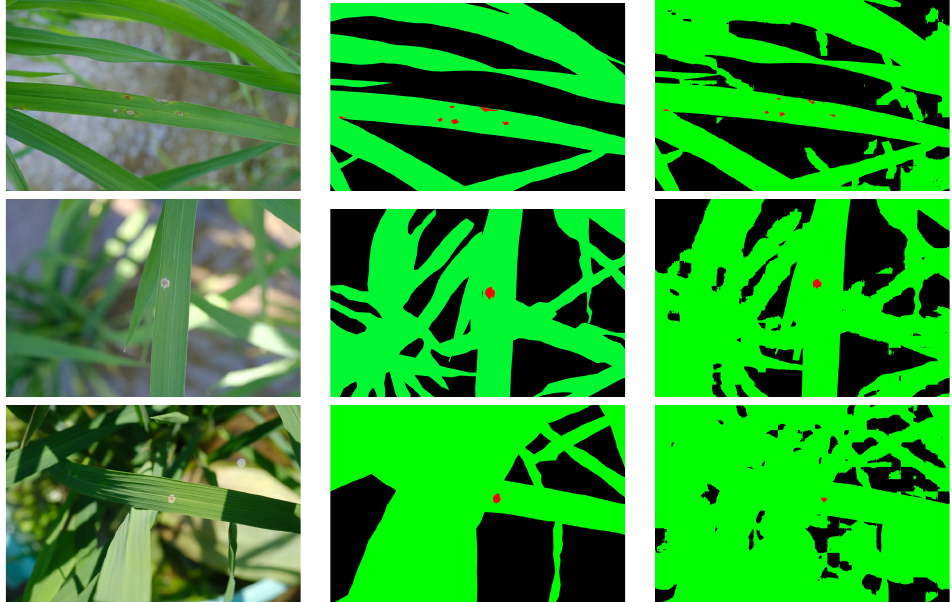
Figure 18. Representative successful Rice blast images: source images ( left ), GT ( center ), and results ( right